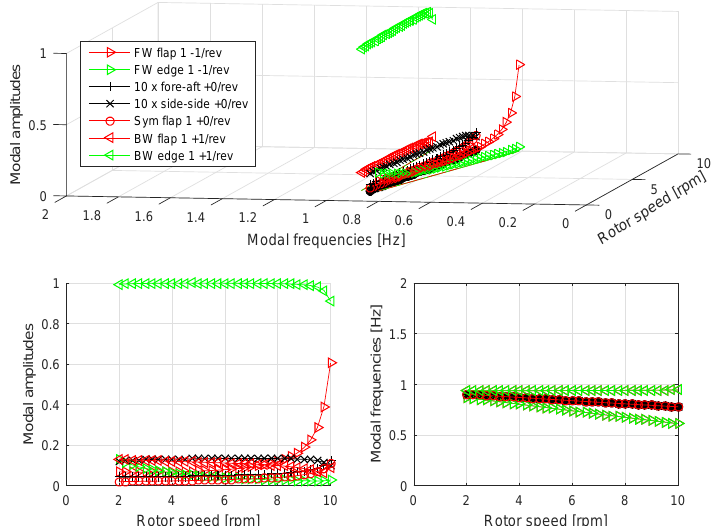
Figure 10. Harmonic modal components for the three-bladed turbine mode dominated by backward whirling (BW) of the rotor in the edgewise DOF. Plot layout as in Fig.